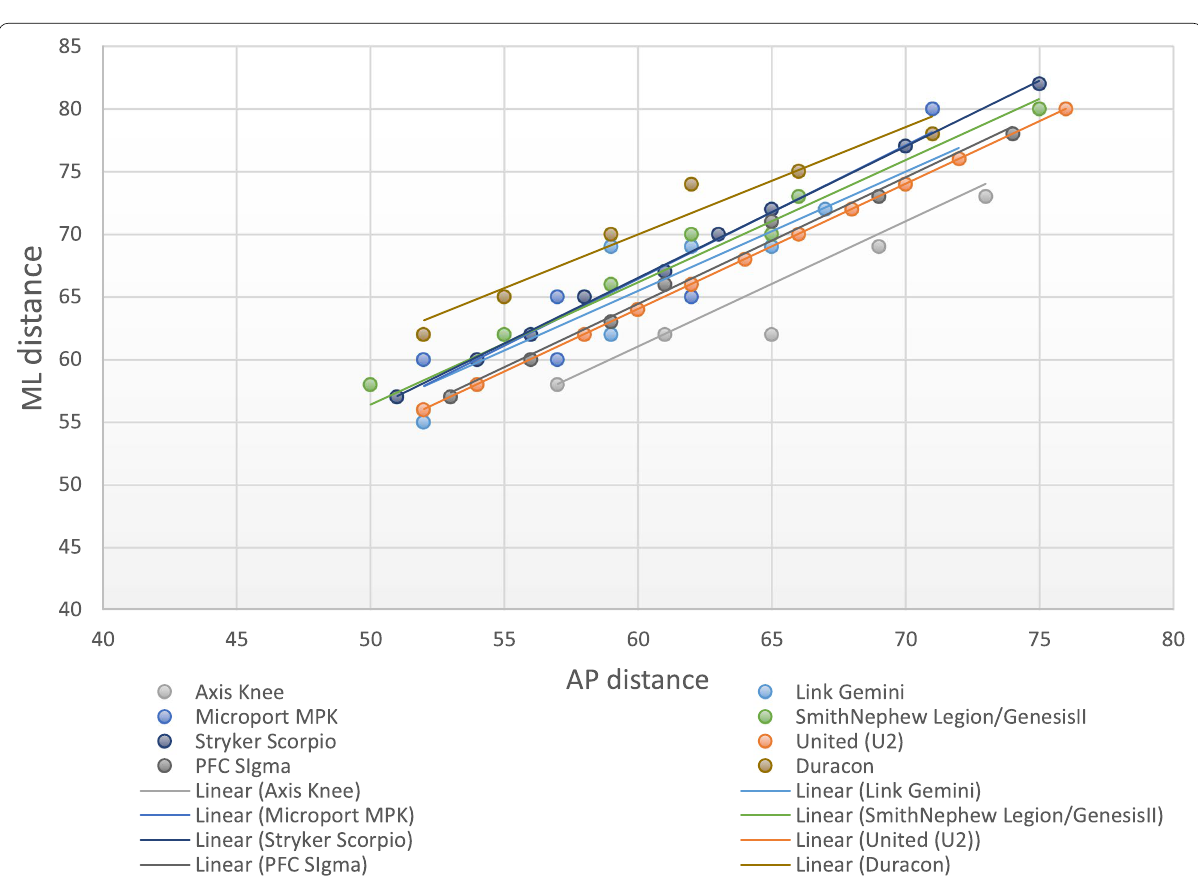
a No uniform sizing categories exist among companies.